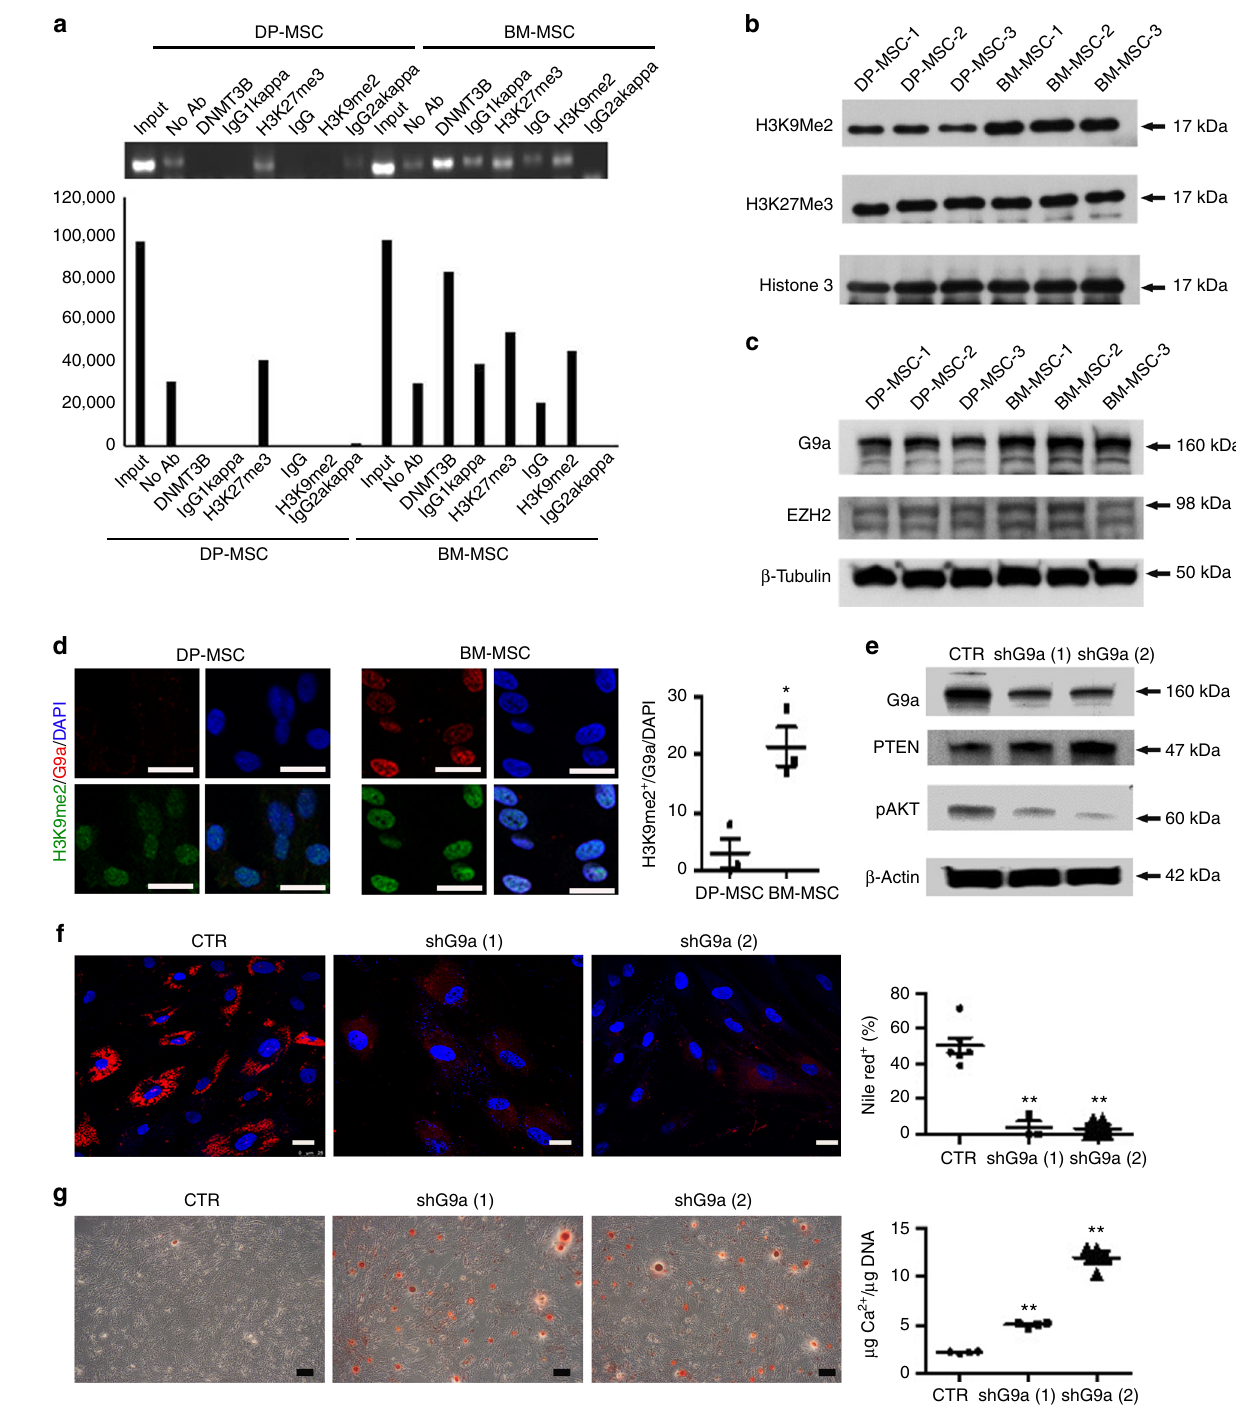
Fig. 6 G9a suppresses PTEN expression to promote adipogenesis and inhibit osteogenesis. DNMT3B and H3K9me2 are abundant at the promoter of upstream 123 – 329 bp PTEN locus in BM-MSCs compared with DP-MSCs. a ChIP analysis for determining the occupancy of PTEN promoter by DMNT3B and repressive marks. Below: Quanti fi cation of the results. Western blotting ( b , c ) and immuno fl uorescence ( d ) showed that BM-MSCs increased in the protein level of H3K9Me2 and master regulator, G9a. Bar = 25 μ m. e Lentiviral knockdown of G9a in BM-MSCs increased PTEN and decreased AKP phosphorylation. f G9a knockdown cells were induced for adipogenic differentiation for 2 weeks and stained by nile red staining. Bar = 25 μ m. Right Quanti fi cation of nile red positive cell percentages. g The cells were also induced for osteogenic differentiation for 3 weeks and stained by Arsenazo III kit. Bar = 200 μ m. Right Quanti fi cation of the calcium contents relative to DNA contents. Results are expressed as the mean ± SD of three independent